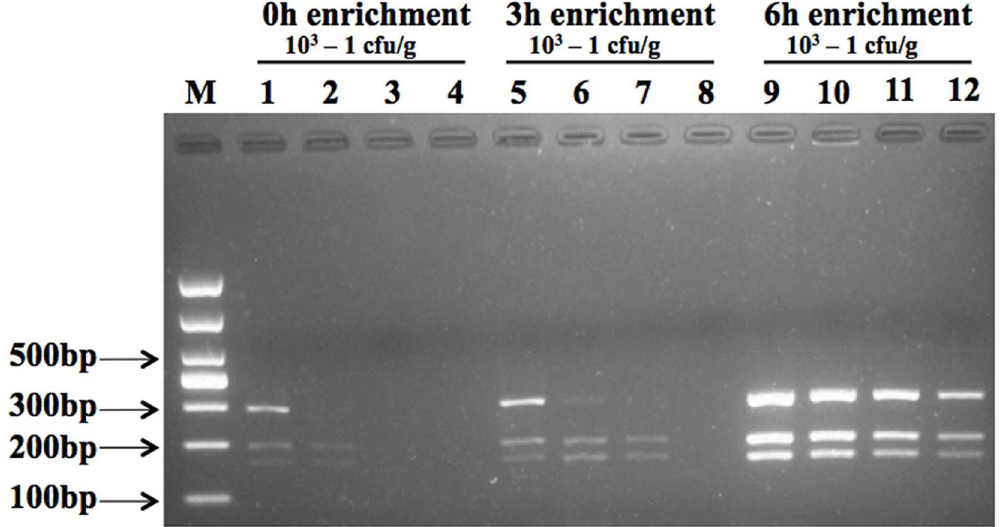
Fig 7. Detection of multiplex PCR assay on fresh-cut cantaloupe inoculated with 10 3 –1 cfu/g following prior enrichment. Lane M shows 1000 bp DNA marker. Lanes 1 to 4, lanes 5 to 8, and lanes 9 to 12 show amplicon results after 0, 3, 6 h enrichment, respectivelyfor L . monocytogenes , E . coli O157:H7, and S . aureus on fresh-cut cantaloupe that had beeninoculatedwith 1.8 × 10 3 –1 cfu/g, 1.1 × 10 3 –1 cfu/g, and 1.4 × 10 3 –1